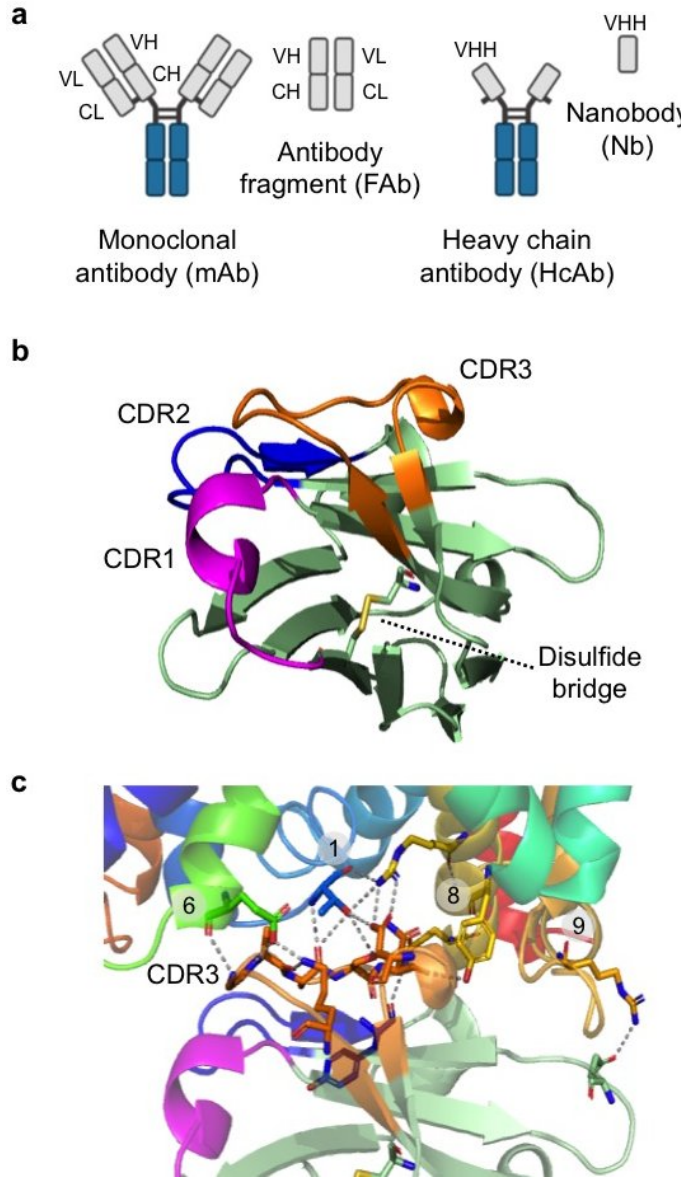
Figure 3. Nanobodies in membrane protein structural biology. ( a ) Traditional monoclonal antibodies (mAb) and their fragments (Fab) vs. heavy chain antibodies (HcAb) and nanobodies (Nb). ( b ) Nanobody structure (PDB ID: 6f2g) [101], showing complementary determining regions (CDR) 1 (magenta), 2 (blue), and 3 (orange) and the disulfide bridge established between Cys 22 and Cys 96. ( c ) Extensive interactions were found between the side chains and backbones of the nanobody CDR3 (orange) and the bacterial amino acid transporter BasC (PDB ID: 6f2g) [101]. CDR3 interacts with residues from BasC transmembrane domains (TMs) 1, 6, 8 and 9.